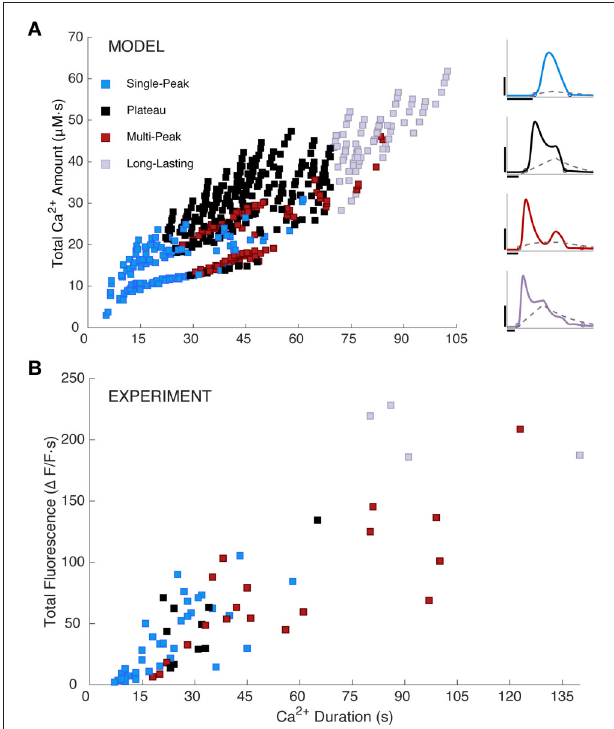
FIGURE 4 | Simulated and measured Ca 2 + responses. (A) Simulated total Ca 2 + amount (the area under the [Ca 2 + ] cyt curve) vs. Ca 2 + duration as defined in section Materials and Methods. Model responses were generated by choosing IP 3 parameter sets as specified in section Materials and Methods and Table 1. Response types are indicated as shown. The right panel repeats example Ca 2 + traces from Figure 2A, column 3 with their respective IP 3 time courses added. The IP 3 parameters are as follows (in order, A , d rise , r rise , d dec ): 0.2, 10, 0.2, 90 (SP); 0.375, 34, 0.002, 110 (PL); 0.26, 41, 0.15, 200 (MP); 0.6, 39, 0.002, 220 (LL). Horizontal scale bars, 10s; vertical scale